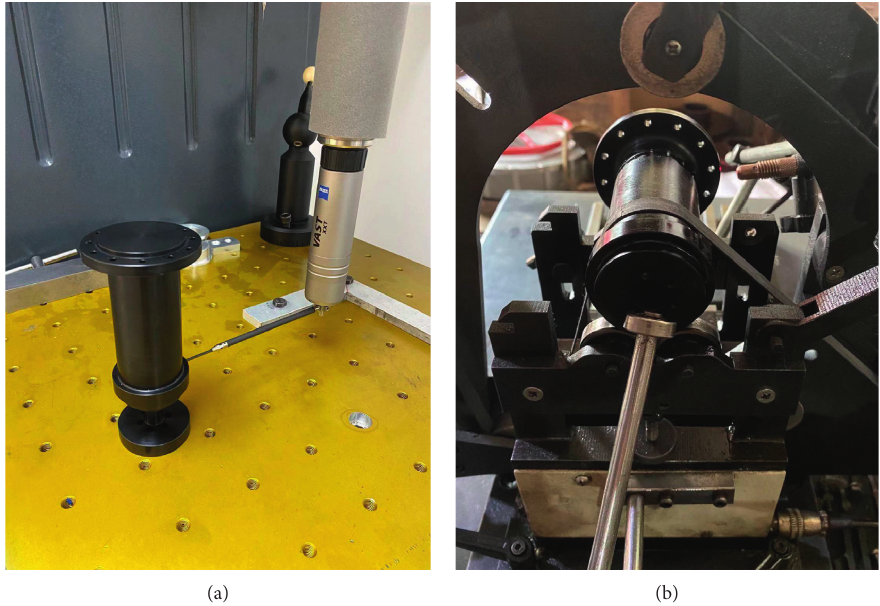
Figure 11: The setup picture for measuring the geometric and mass parameters of the front shaft. (a) The geometric parameters are measured by a CMM. (b) The mass parameters are measured by a dynamic balancing